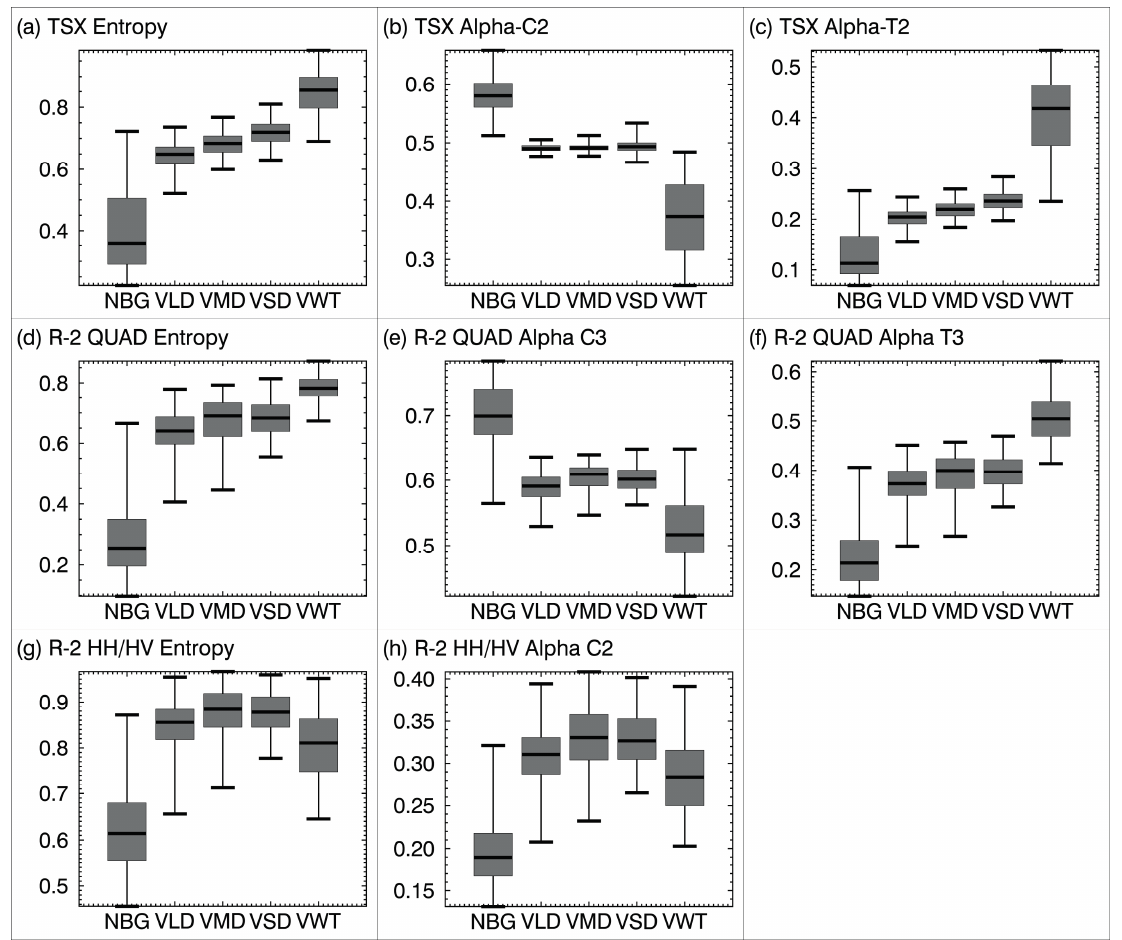
Figure 6. Boxplots of selected features of co-polarized TerraSAR-X data ( a – c ), quad-polarized Radarsat-2 data ( d – f ) and Radarsat-2 pseudo HH/HV data (Entropy/Alpha) ( g , h ) with respect to ground truth land cover reference